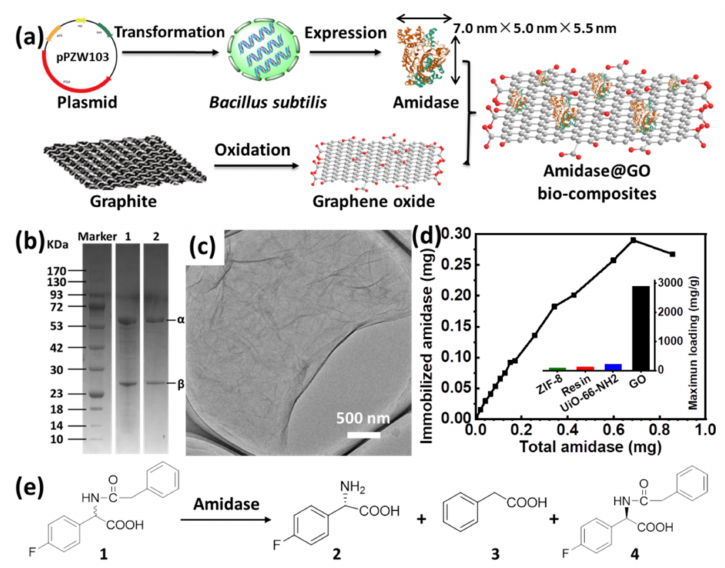
Figure 1. ( a ) Schematic illustration for expression of recombinant amidase, preparation of GO and immobilization of amidase on GO; ( b ) SDS − PAGE of semi-purified (lane 1) and final purified (lane 2) amidase; ( c ) TEM image of GO; ( d ) immobilized amidase on GO as a function of the total amount of amidase and the comparison of maximum loading capacity of amidase on various supports (inset); ( e ) schematic illustration for kinetic resolution of racemic N-phenylacetyl-4-fluorophenylglycine (1) to produce L-4-fluorophenylglycine (2) by